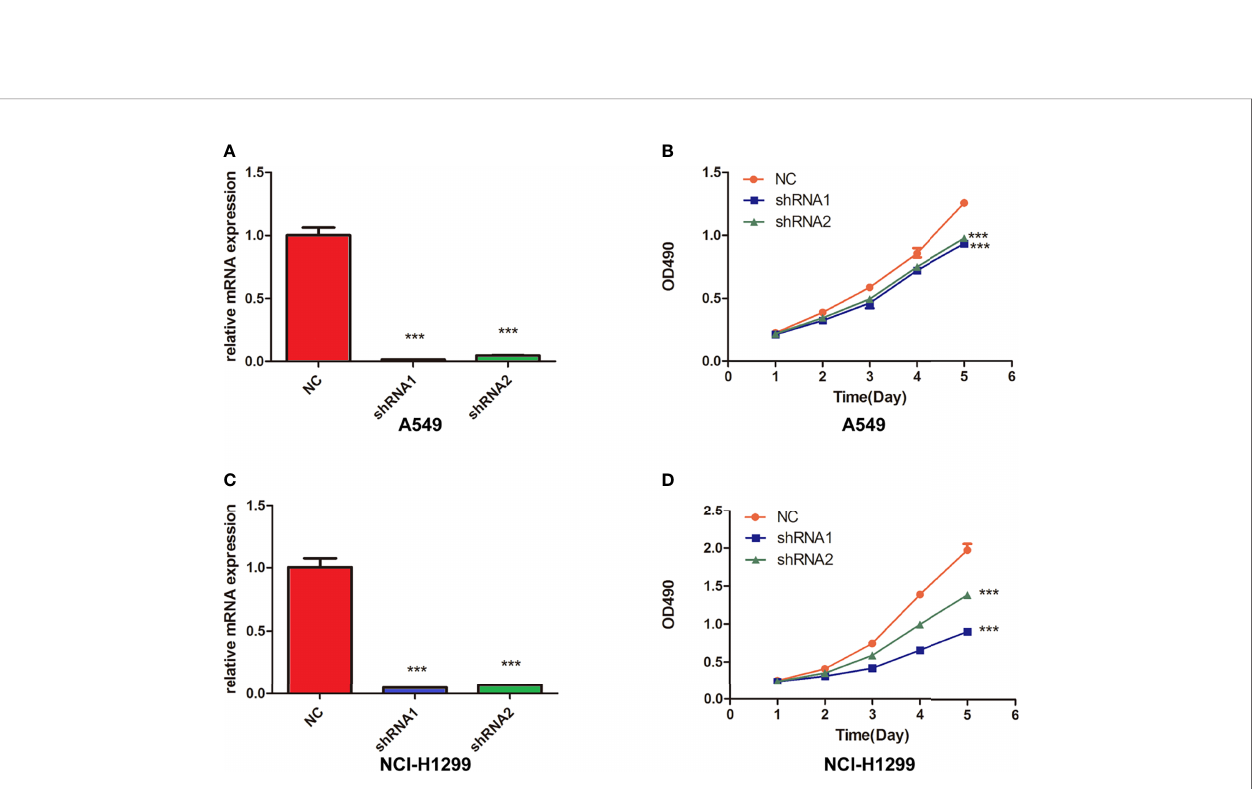
FIGURE 10 | Knockdown of FUCA2 Inhibited the cell viability in Lung Cancer Cells. (A) A549 and cells were transfected with si-FUCA2, the level of FUCA2 was evaluated by qRT-PCR. (B) The cell viability of A549 cells was examined by MTT assay. (C) NCI-H1299 cells were transfected with si-FUCA2, the level of FUCA2 was evaluated by qRT-PCR. (D) The cell viability of NCI-H1299 cells was examined by MTT assay. ***P <